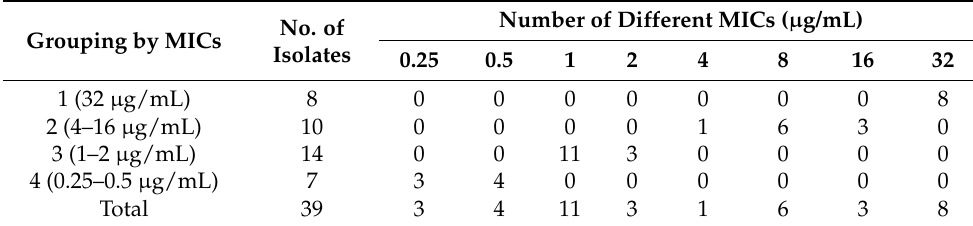
Table 3. The number distribution of different MICs among four groups.